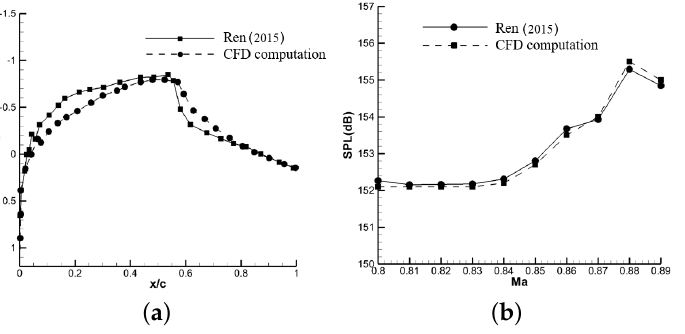
Figure 2. Comparison of results [18]. ( a ) Pressure Coefficient along the flow direction on the wall (c is the chord). ( b ) Sound Pressure Levels(SPL)at different Mach numbers (x/c =